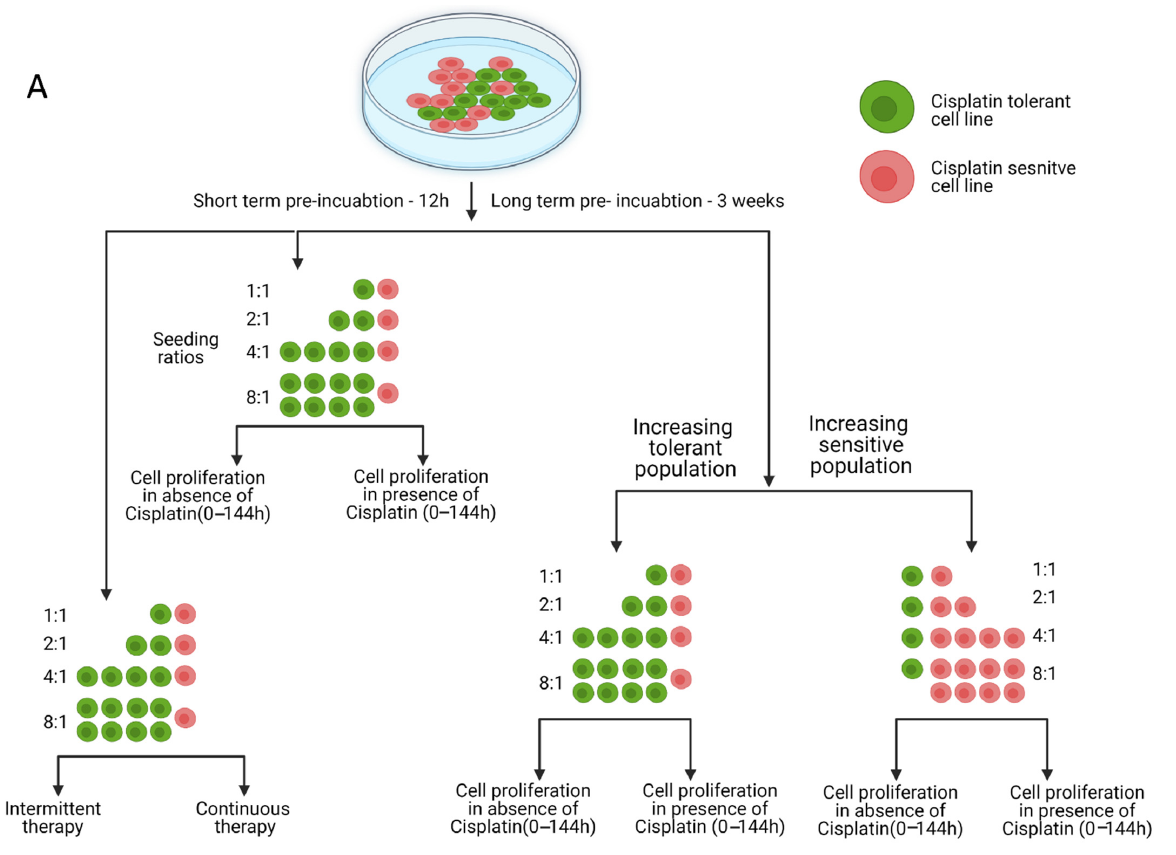
Figure 1. Schematic summarizing the experiment and the source of data used in developing the theoretical cell growth models. ( A ) The schematic representation of the different incubation dura- tion, ratios, and treatments used for generating the data to develop the mathematical model. ( B )